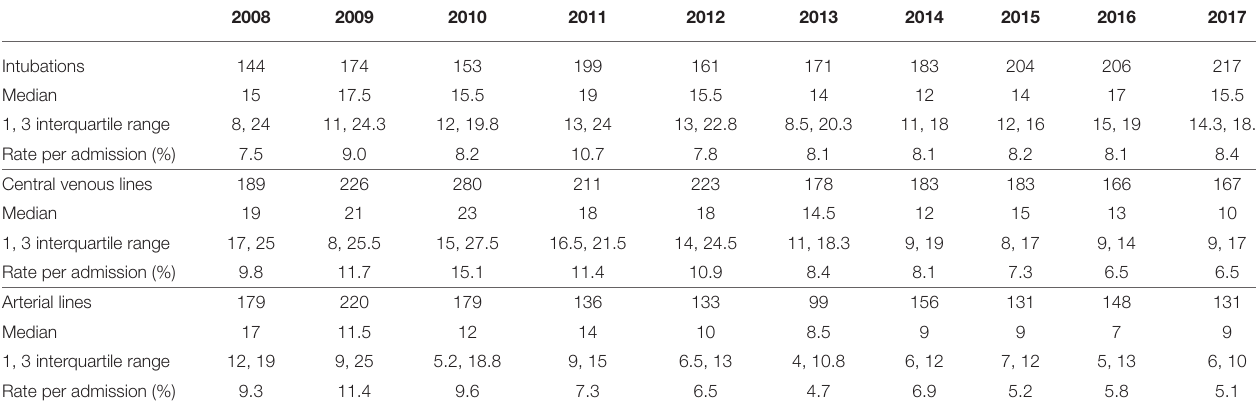
TABLE 3 | Absolute count, median and interquartile range per Fellow per year, and Rate per admission of Intubations, Central Venous Lines, and Arterial Lines.